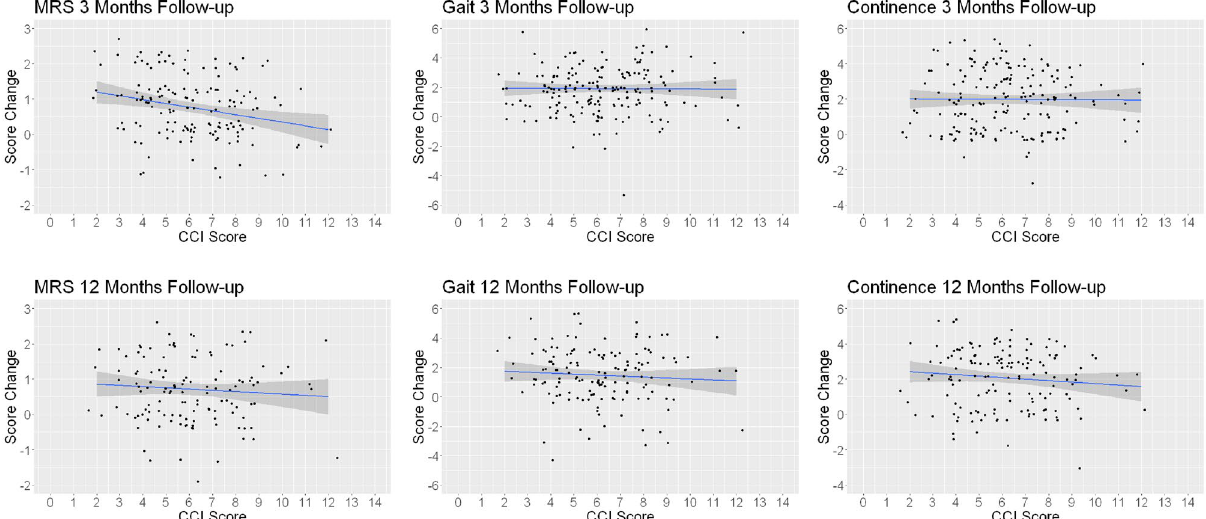
Figure 3. Linear regression analysis of changes of the clinical score at the follow-up as compared with the preoperative scores was not related to the preoperative CCI. The regression line is shown and in addition the individual data visualized as jitter plot. The jitter plot is like a scatter plot but adds random noise to better see the information contained in the data, when there is a lot of